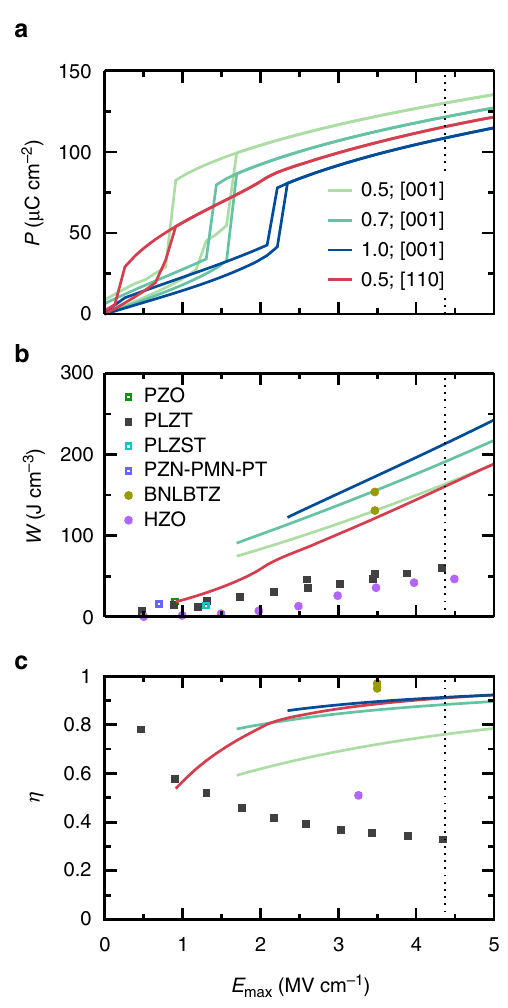
Figure 5 | The computed energy storage performance of selected Bi 1 (cid:2) x Nd x FeO 3 solid solutions. ( a ) The P – E hysteresis curves. ( b ) The energy density as a function of the magnitude of the maximum applied electric field, with the discrete symbols representing the best available experimental data from different types of materials, that is, lead-based (PbZrO 3 (PZO) 34 , PLZT 5,6,35,44 , (Pb,La)(Zr,Sn,Ti)O 3 (PLZST) 33 and Pb(Zn 1/3 Nb 2/3 )O 3 -Pb(Mg 1/3 Nb 2/3 )O 3 -PbTiO 3 (PZN-PMN-PT) 33 ), and lead-free (BNLBTZ 10 and HZO 11 ) systems. ( c ) The efficiency as a function of the magnitude of the maximum applied electric field. The dotted vertical line denotes the estimated intrinsic breakdown field for BFO 30,31 .